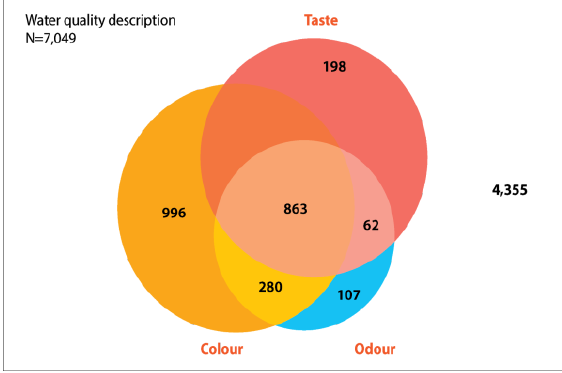
Figure 1: Water Quality in Indonesia